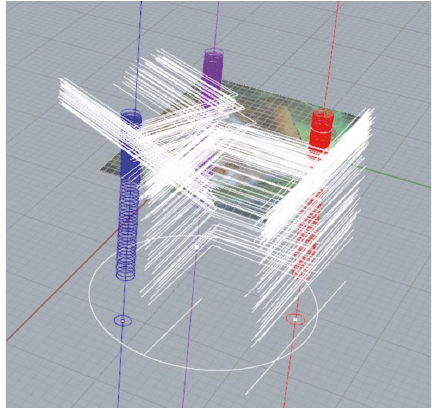
Figure 1: Working surface of the CAD program Rhinoceros 5. The markings of the reference marks are arranged in piles and colored in red, blue, and lilac. The adjustment lines for the microgrinding images are marked in